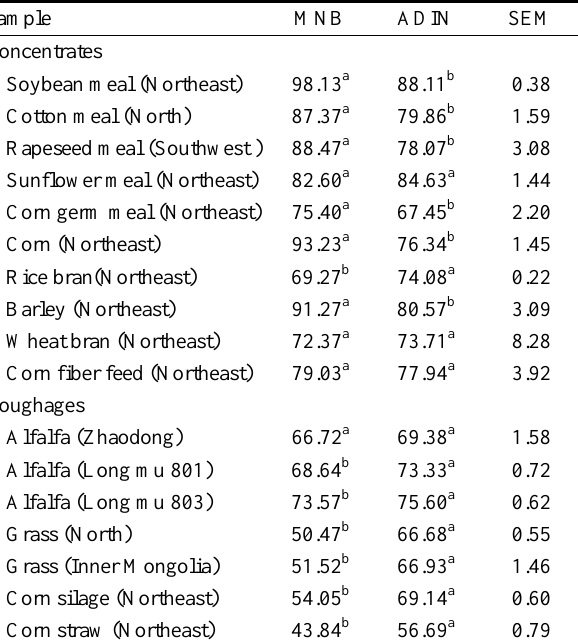
method, original three-step in vitro method and modified three-